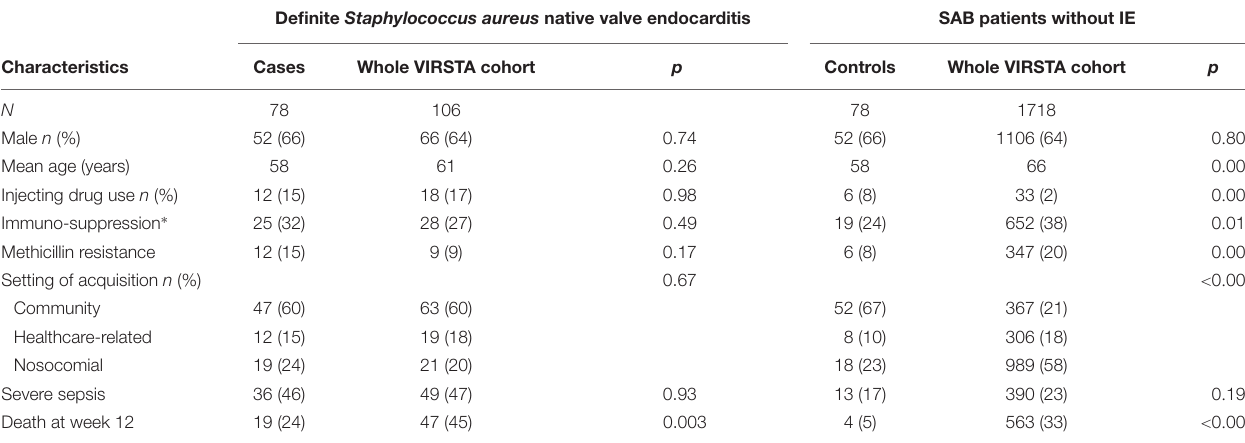
TABLE 1 | Comparison of the characteristics of the patients enrolled in the case control genetic study and in the whole cohort. Definite Staphylococcus aureus native valve endocarditis SAB patients without IE